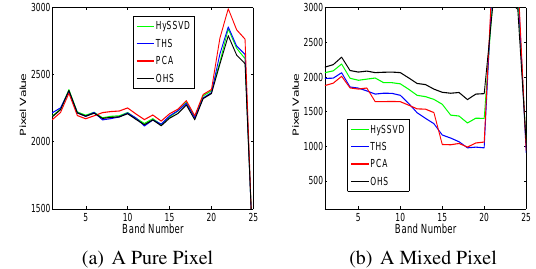
Figure 10: Example Spectral signatures showing spectral distor-